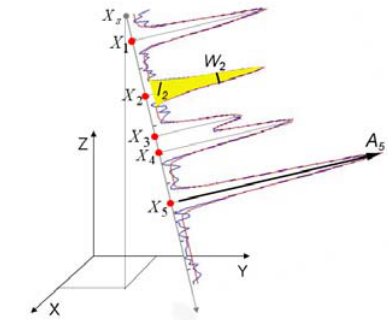
Figure 2. 3D points and attributes derived from a waveform The vector